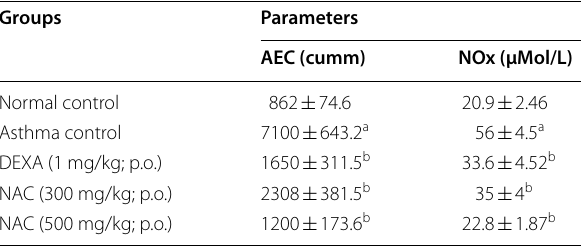
Table 2 Effects of NAC as compared to the reference